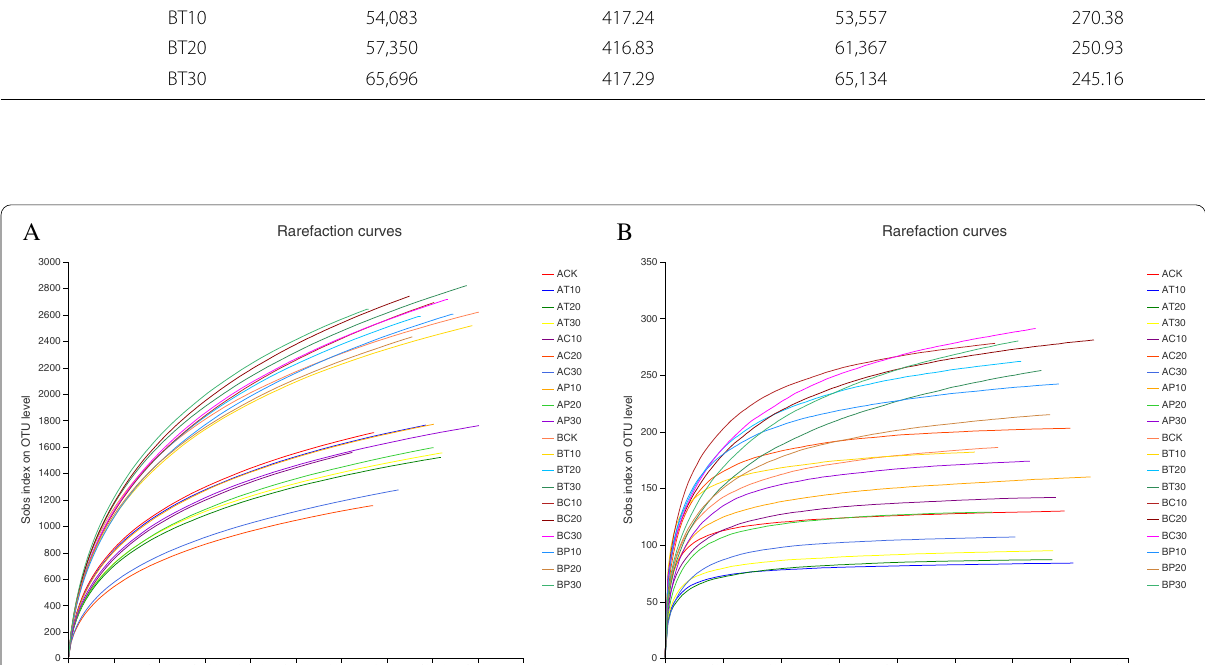
The contribution of the 1st and 2nd principal com- ponents of the bacterial communities based on PCoA weighted using Bray-Curtis and UniFrac distances were 28.15%, 23.53%, 33.69%, and 25.09%, respectively (Fig. 2).